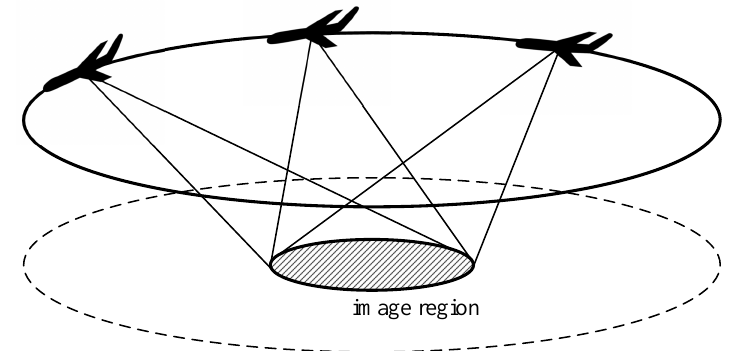
Figure 1. The collection geometry of video SAR on a circular path. SAR: synthetic aperture